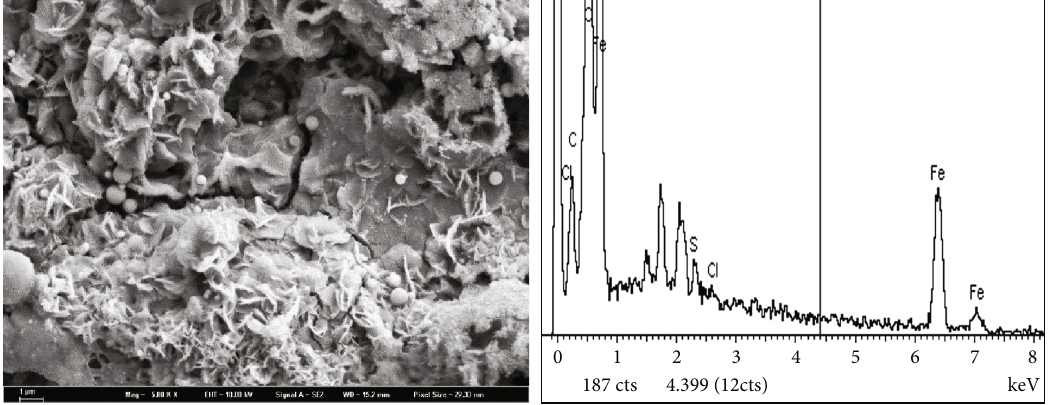
Figure 5: Corrosion products and EDS results of bridge deck surface.